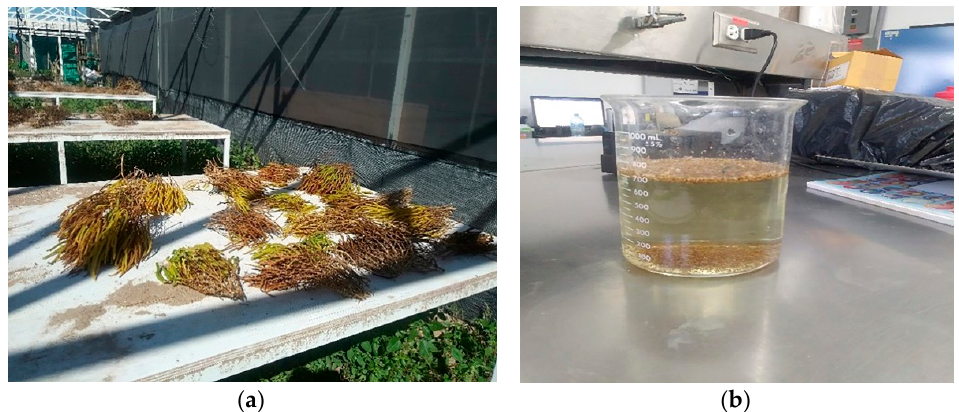
Figure 2. Sundried mature Salicornia bigelovii (Torr.) plants: ( a ) for seed separation, ( b ) at the CIBNOR Plant Physiology Technical